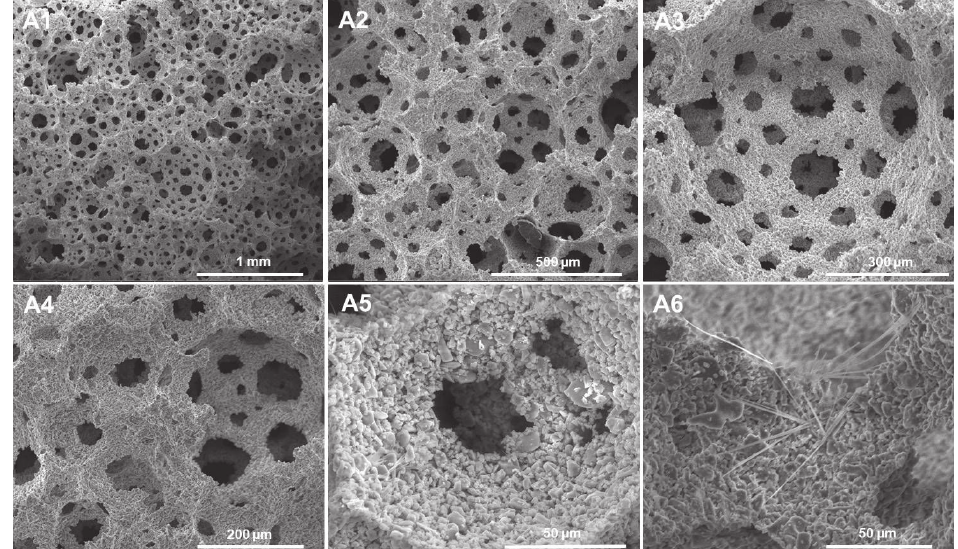
Figure 2. SEM micrographs of BGNb10 scaffolds (A1, A2, A3, A4, A5, A6) prepared by gelcasting method and sintered at 850 ºC/2